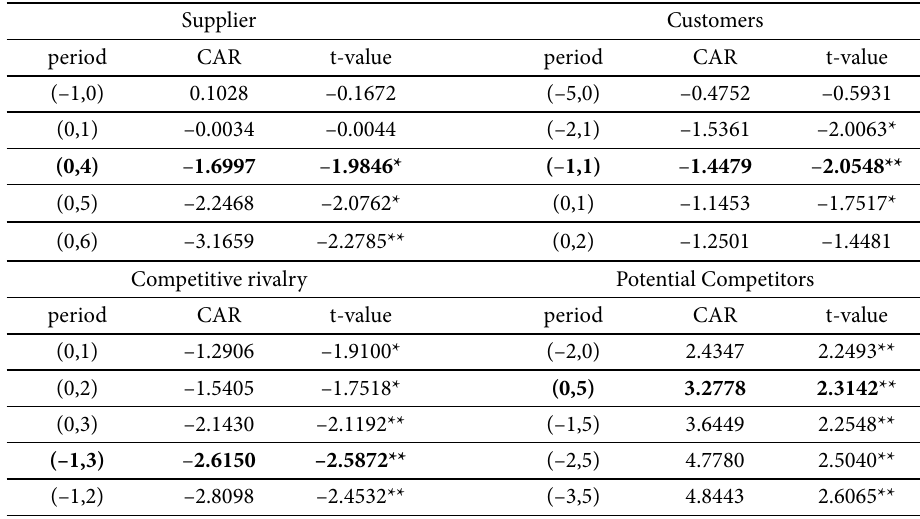
Table 2. Window analysis for patent infringement